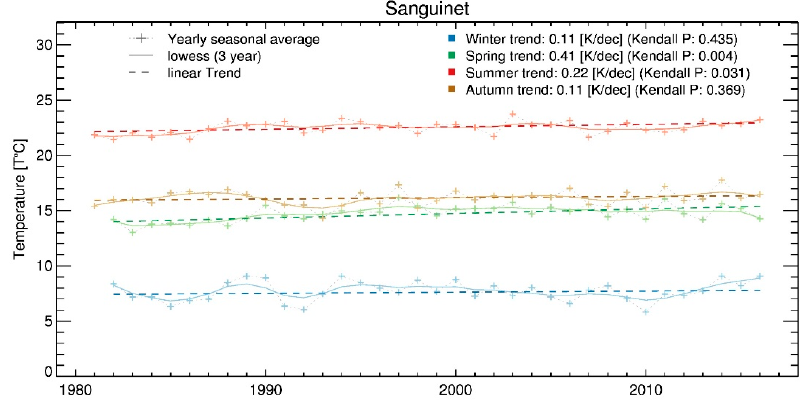
Figure 12. Seasonal trends at Lake Sanguinet, whereas the spring and summer trend are categorized as ‘significant’ ( p -value < 0.05); the winter and autumn trends 0.11 K/decade are categorized ‘insignificant’ ( p -values > 0.05).